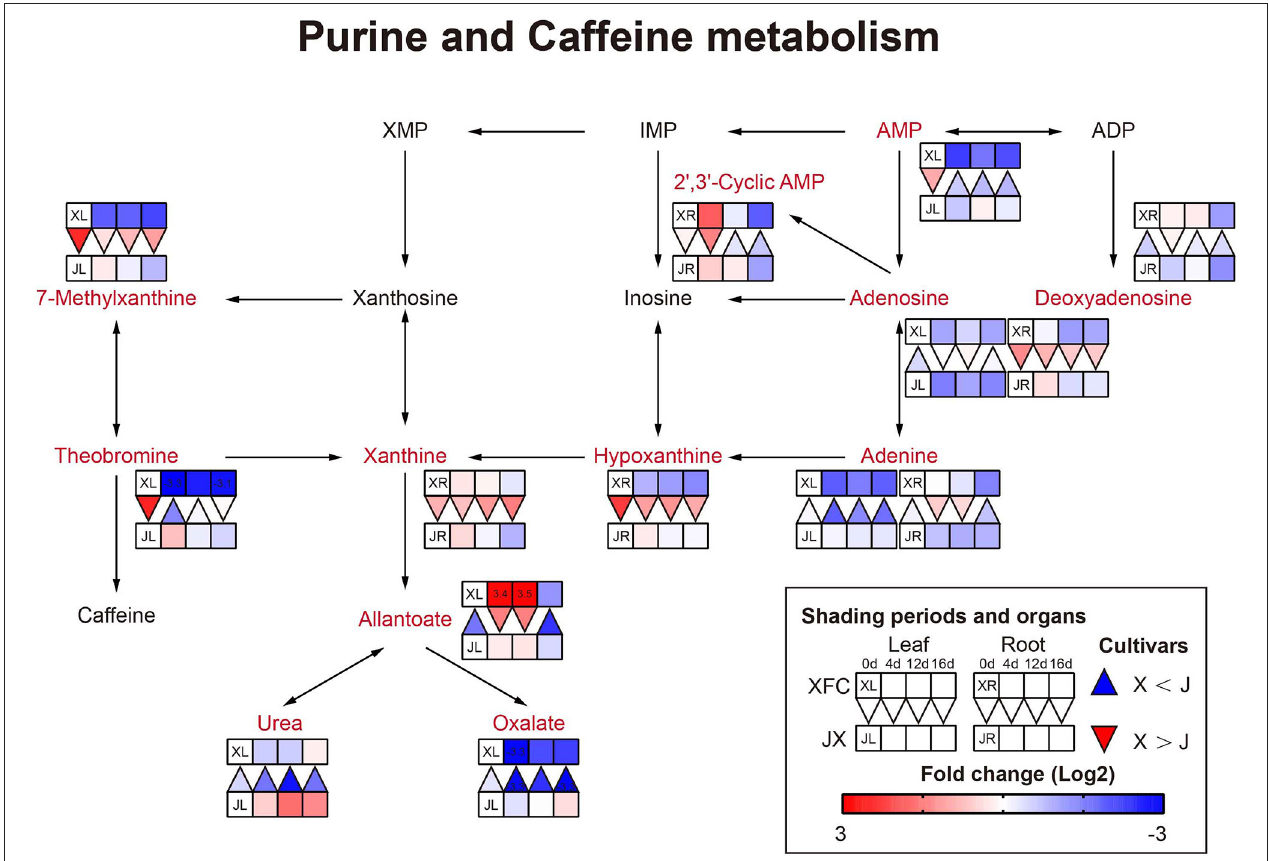
FIGURE 10 | The metabolite differences during purine and caffeine metabolism in the two tea cultivars under different shading periods. The identified metabolites are marked with a red color. In the legend, the squares at two lines express the different cultivars, “Xiangfeicui” (XFC) and “Jinxuan” (JX). The squares at eight columns express the different shading periods. The squares in the left part represent the leaves and the right part represents the roots. Blue indicates relatively low and red indicates relatively high intensity. The red triangle indicates relatively higher intensity of metabolites in XFC (X) than in JX (J), and the inverted blue triangle indicates relatively lower intensity of metabolites in XFC (X) than in JX (J). The degree of change was described with the depth of color, and the depth of the colors is based on the log2-fold change value between the samples. XL, leaf of “Xiangfeicui”; XR, root of “Xiangfeicui”; JL, leaf of “Jinxuan”; JR, root of